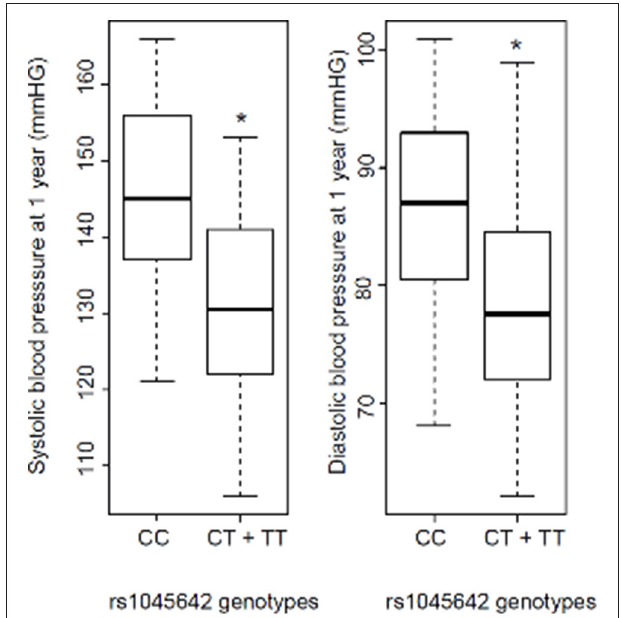
FIGURE 1 | Systolic blood pressure (SBP) and diastolic blood pressure (DBP) 1 year after kidney transplantation according to rs1045642 genotype (CC vs. CT + TT). * p = 0.003 and 0.01 for SBP and DBP, respectively (Mann–Whitney